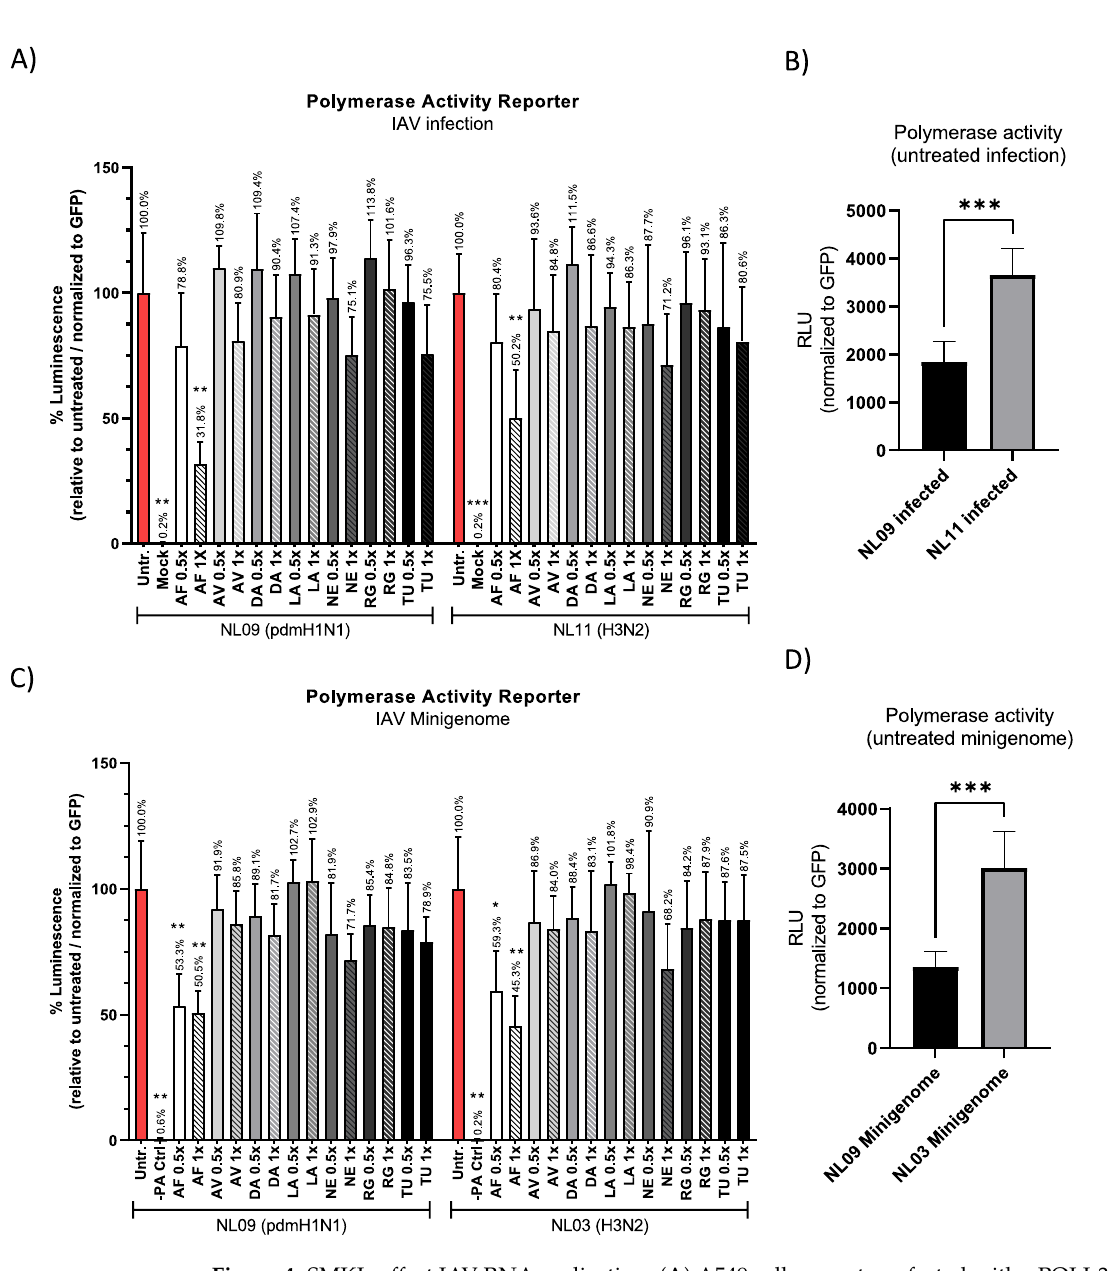
Figure 4. SMKIs affect IAV RNA replication. ( A ) A549 cells were transfected with pPOLI-358-FFluc and pmaxGFP plasmids. At 24 hpt, cells were infected with NL09 or NL11 at MOI = 1 +/ − the indicated SMKIs at [0.5 × or 1 × ] max concentrations. At 48 hpt (24 hpi), luciferase activity was measured and normalized to GFP expression (MFI). ( B ) GFP-normalized polymerase activity of untreated NL09- or NL11-infected cells is shown. ( C ) A549 cells were transfected with pPOLI-358-FFluc and pmaxGFP plasmids and co-transfected with NL09 or NL03 minigenome plasmids. At 6 hpt, SMKIs were added to the medium. At 30 hpt (24 h of treatment), luciferase activity was measured and normalized to the GFP MFI. Bars indicate values relative to untreated cells normalized to GFP. ( D ) GFP-normalized polymerase activity of untreated NL09 or NL03 minigenome-transfected cells is shown. Triplicate measurements from triplicate samples ( n = 3); error bars indicate ± standard deviation (SD). *, p < 0.05; **, p < 0.01; ***, p < 0.001. p -values were determined by Brown–Forsythe and Welch ANOVA tests compared to untreated cells.